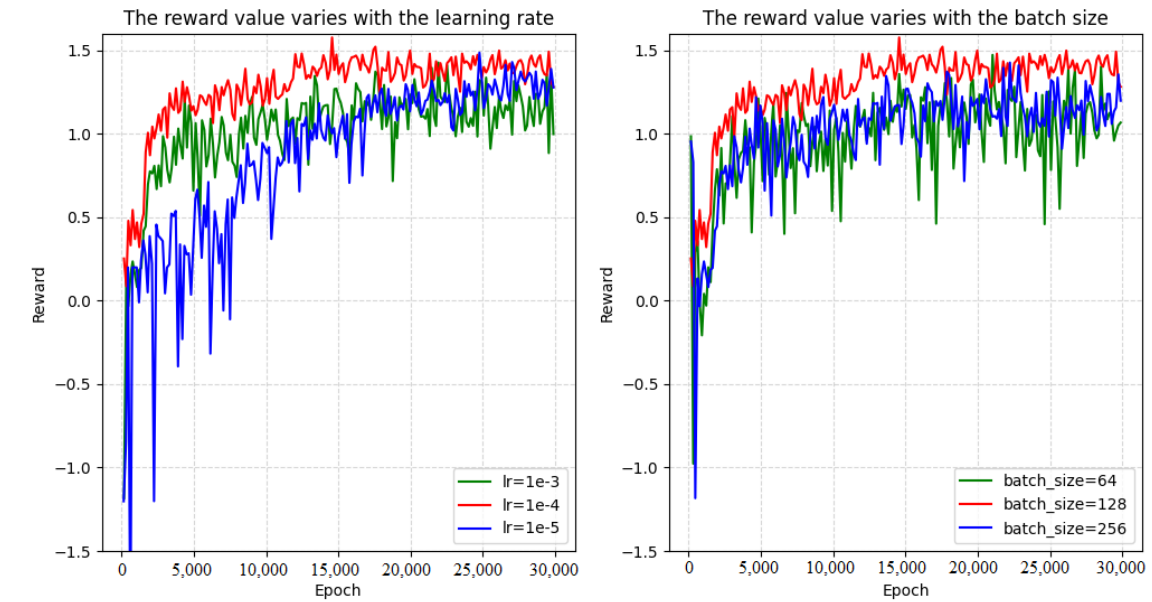
Figure 7. Reward curse change with learning rate and batch